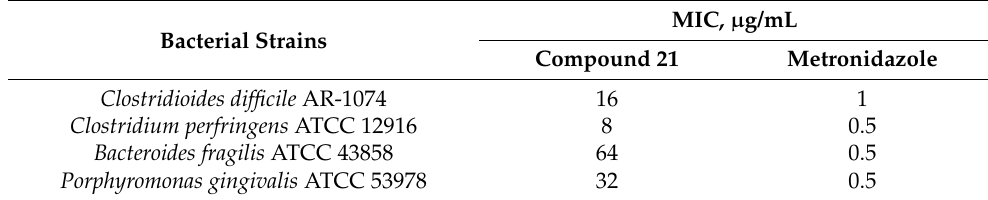
Table 3. The antimicrobial activity of 5-oxopyrrolidine derivative 21 against clinically significant Gram-positive and Gram-negative anaerobic bacteria strains. The data expressed in the table repre- sents minimal inhibitory concentration from 3 technical